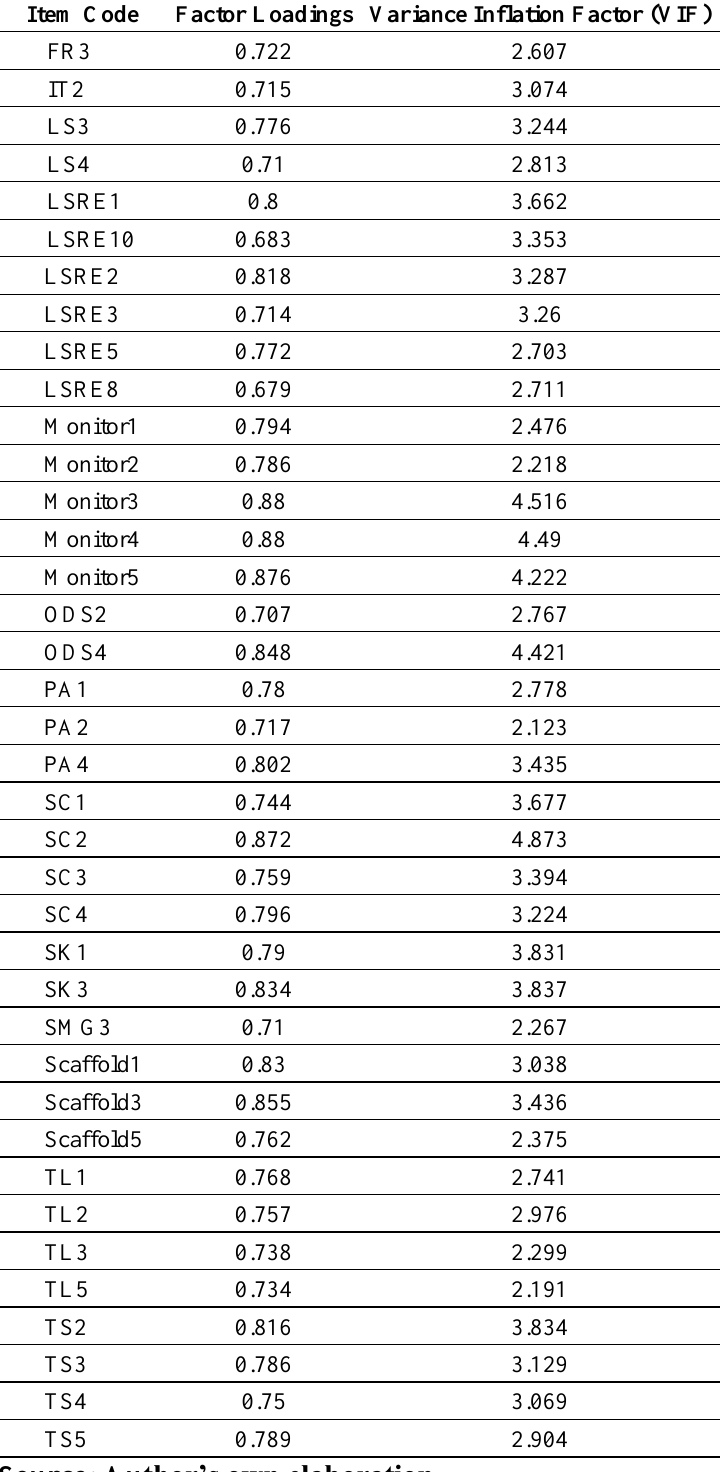
Table.2. Factor Loading and Variance Inflation Factor Item